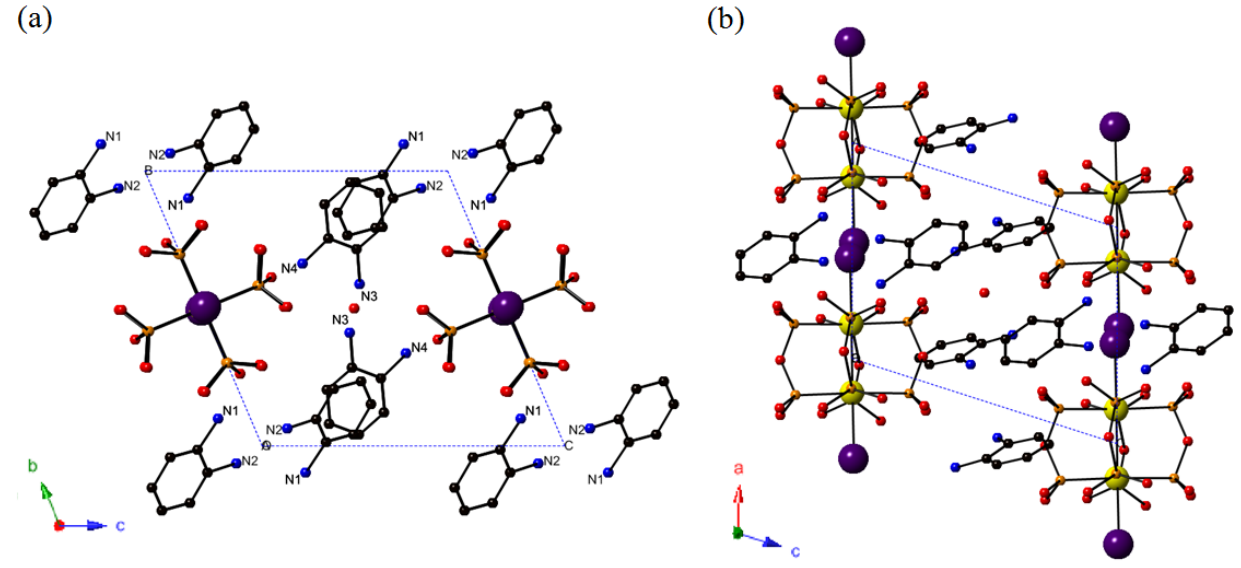
Figure 2. Crystal structure of 1 viewed along (a) a -axis and (b) b -axis. Hydrogen atoms are omitted for clarity. Unit cell is described as blue dashed line. (black, C; blue, N; red, O; orange, P; purple, I; yellow, Pt).